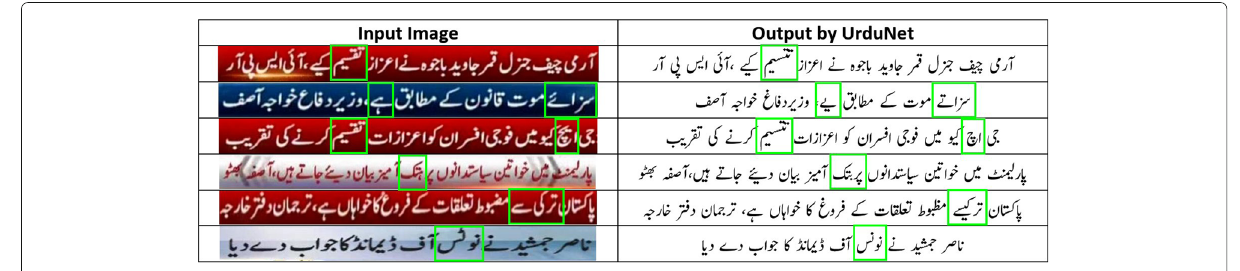
Fig. 15 Typical recognition errors made by UrduNet